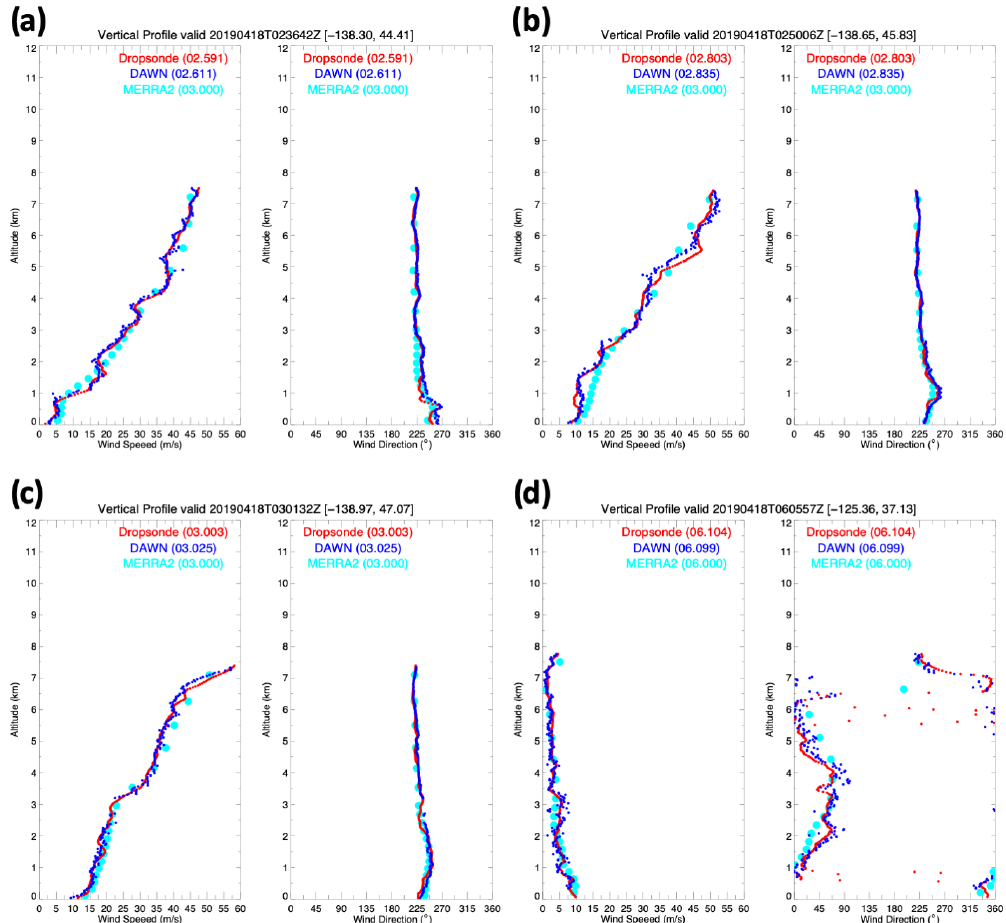
Figure 4. Dropsonde (red), DAWN (blue), and MERRA-2 (cyan) for DAWN profiles at (a) 0236, (b) 0250, (c) 0301, and (d) 0605UTC on 18 April